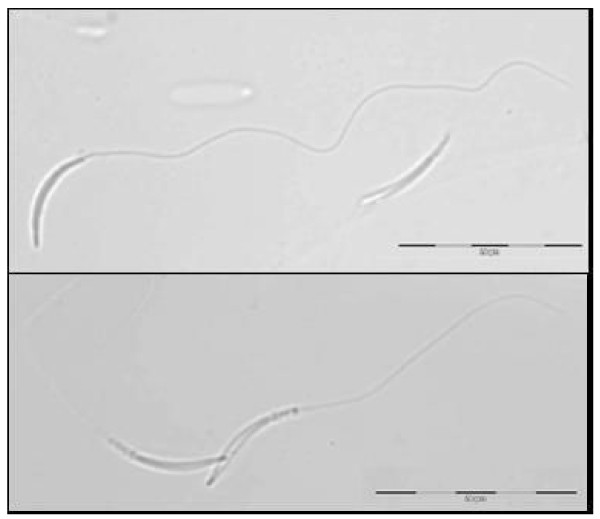
Griffon vulture (Gyps fulvus) spermatozoa normal morphology.